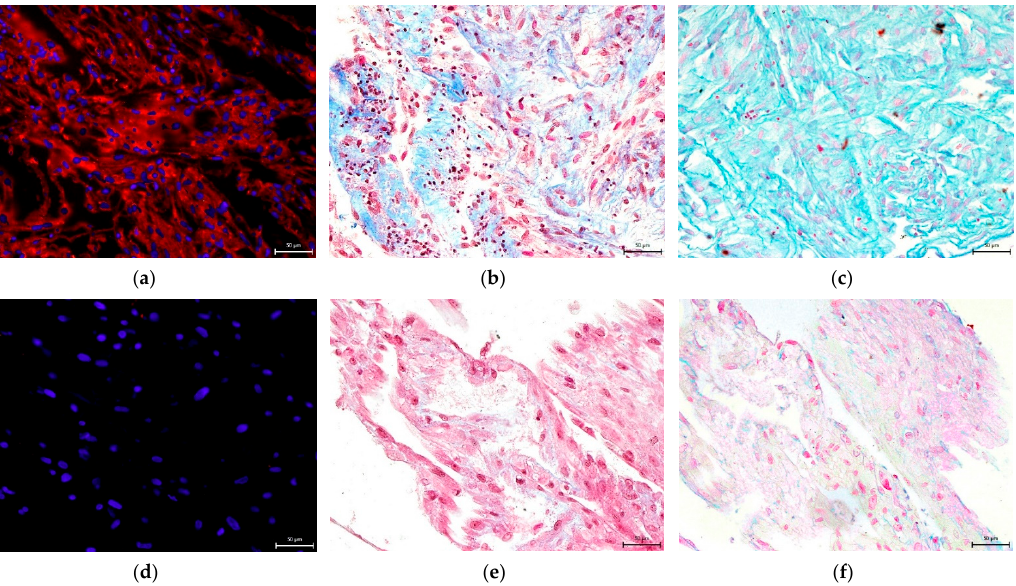
Figure 10. Detection of chondrogenic differentiation in the extracellular matrix of hNDP-SCs culti- vated in the FBS-culture medium. Scale bar 50 μ m: ( a – c ) After 3-week cultivation in chondrogenic differentiation medium; ( d – f ) undifferentiated hNDP-SCs; ( a , d ) immunocytochemical detection of collagen type II (red fluorescence); ( b , e ) histological detection of collagen and procollagen after blue Masson’s trichrome stain (blue areas); ( c , f ) histological detection of acid mucopolysaccharides after Alcian blue stain (turquoise areas).